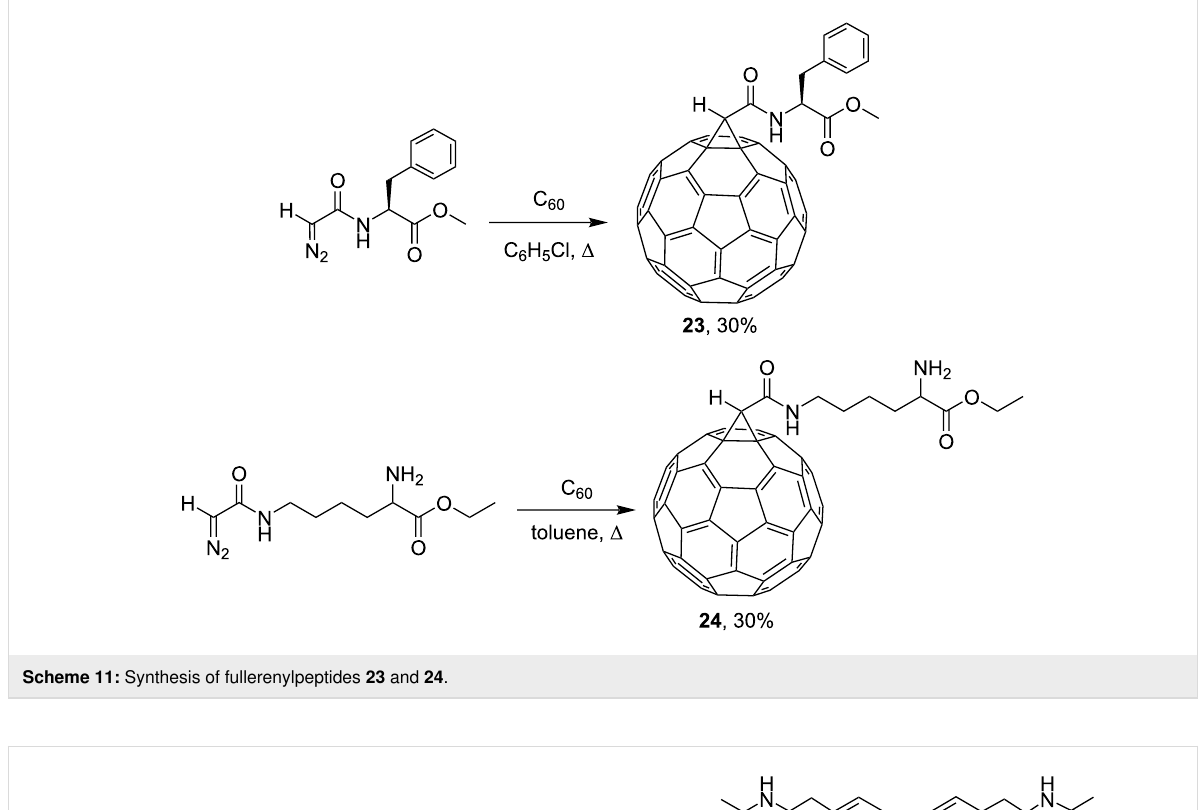
Scheme 11: Synthesis of fullerenylpeptides 23 and 24 .